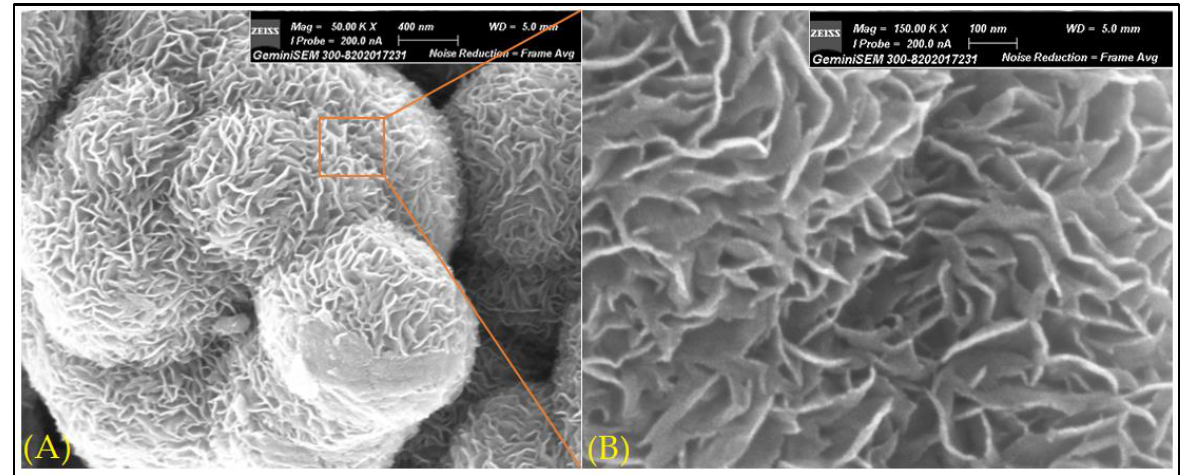
Figure 6. FESEM images of MoS 2 at magnifications of 400 nm ( A ) and 100 ( B ).